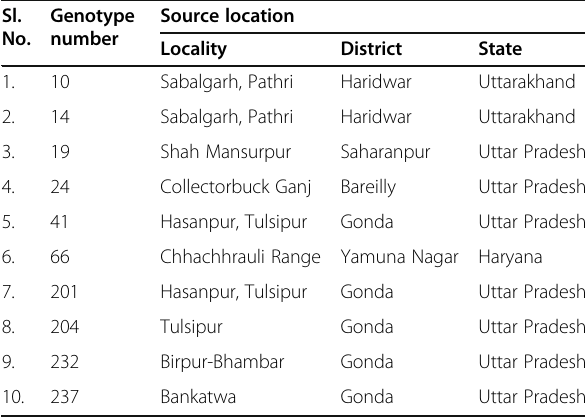
Table 1 Source location of selected genotypes of D. sissoo in the study Sl. Genotype No.